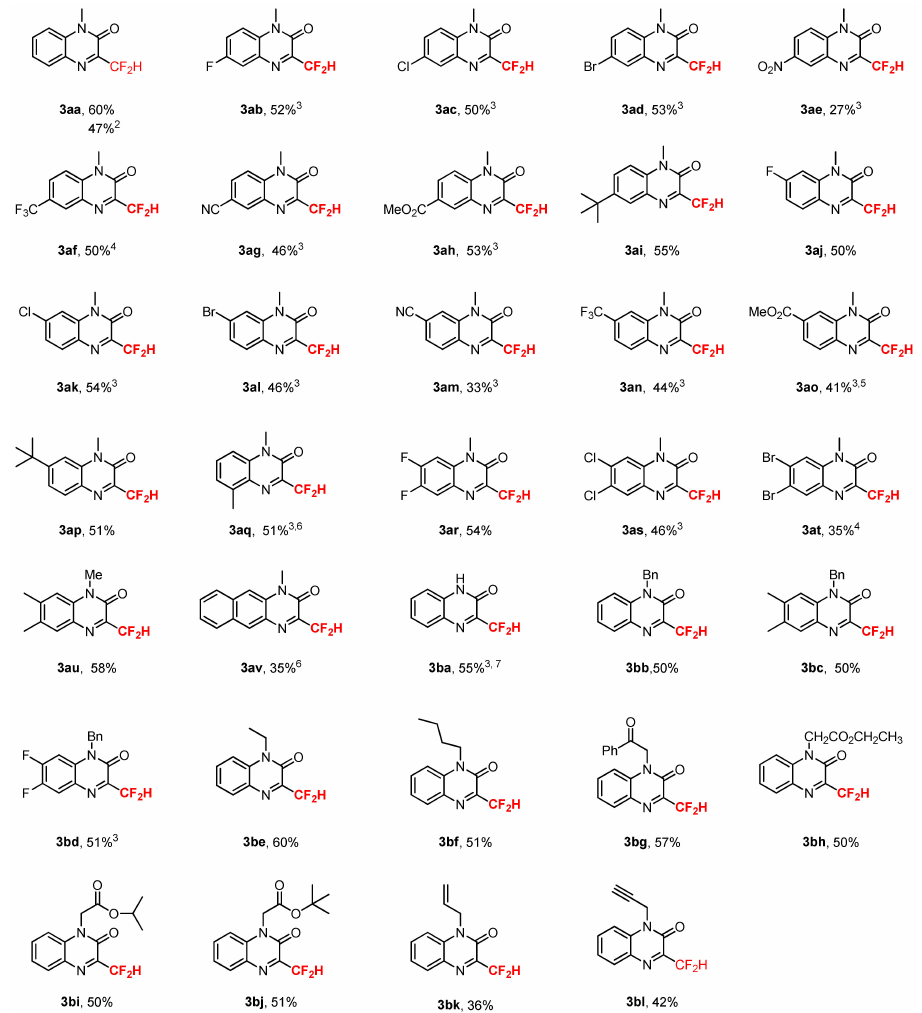
Figure 2. Scope of visible-light-induced difluoromethylation of quinoxalin-2-ones 1 . 1 Reaction con- ditions (unless otherwise specified): 1 (0.2 mmol, 1.0 equiv.), PC II (3 mol%), reagent 2 (0.4 mmol, 2.0 equiv.), LiOH (0.4 mmol, 2.0 equiv.), EtOAc(3.0 mL), 25 ◦ C, overnight (18 h). Isolated